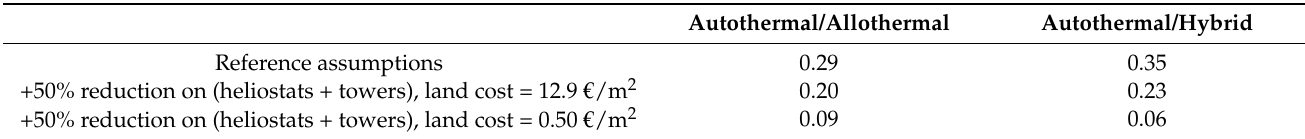
Table 6. Turnaround biomass price ( € /kg): autothermal/solar, DC = 150,000 kg H 2